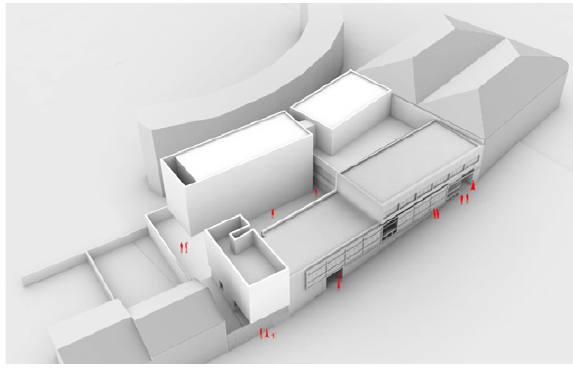
Figure 14. Exterior volume of proposed solution